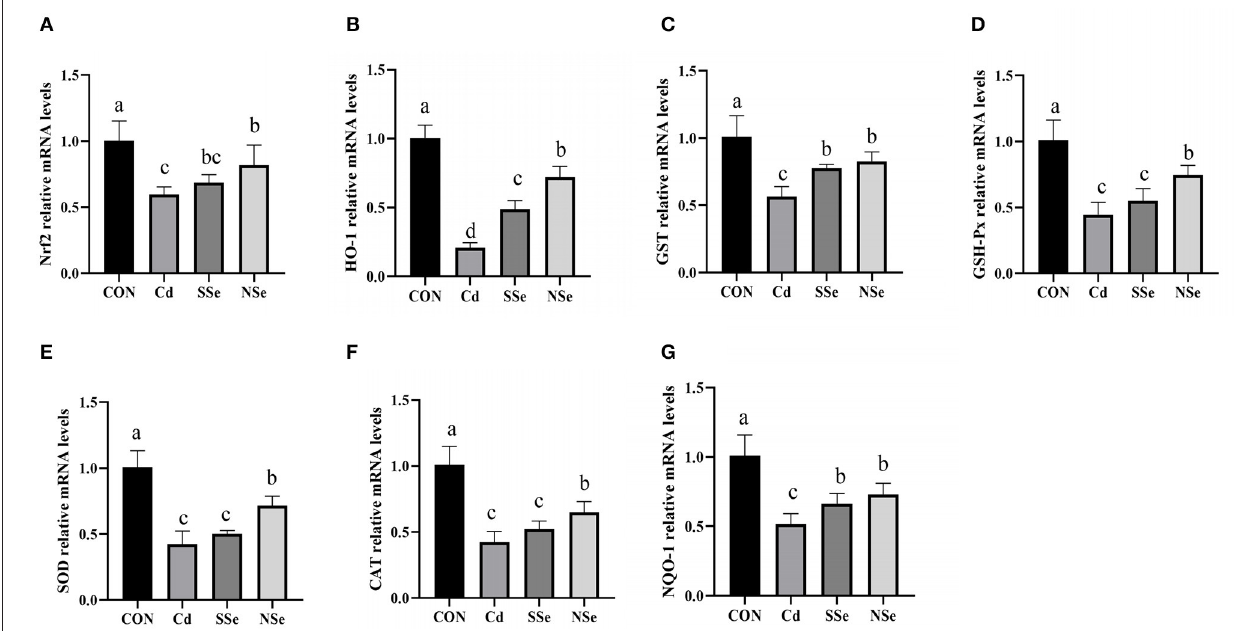
FIGURE 6 | The relative mRNA expression levels of Nrf2, HO-1, GST, GSH-Px, SOD, CAT and NQO-1 in the liver for this experiment. (A) Nrf2, (B) HO-1, (C) GST, (D) GSH-Px, (E) SOD, (F) CAT, (G) NQO-1. Different letters represented significant difference ( P <